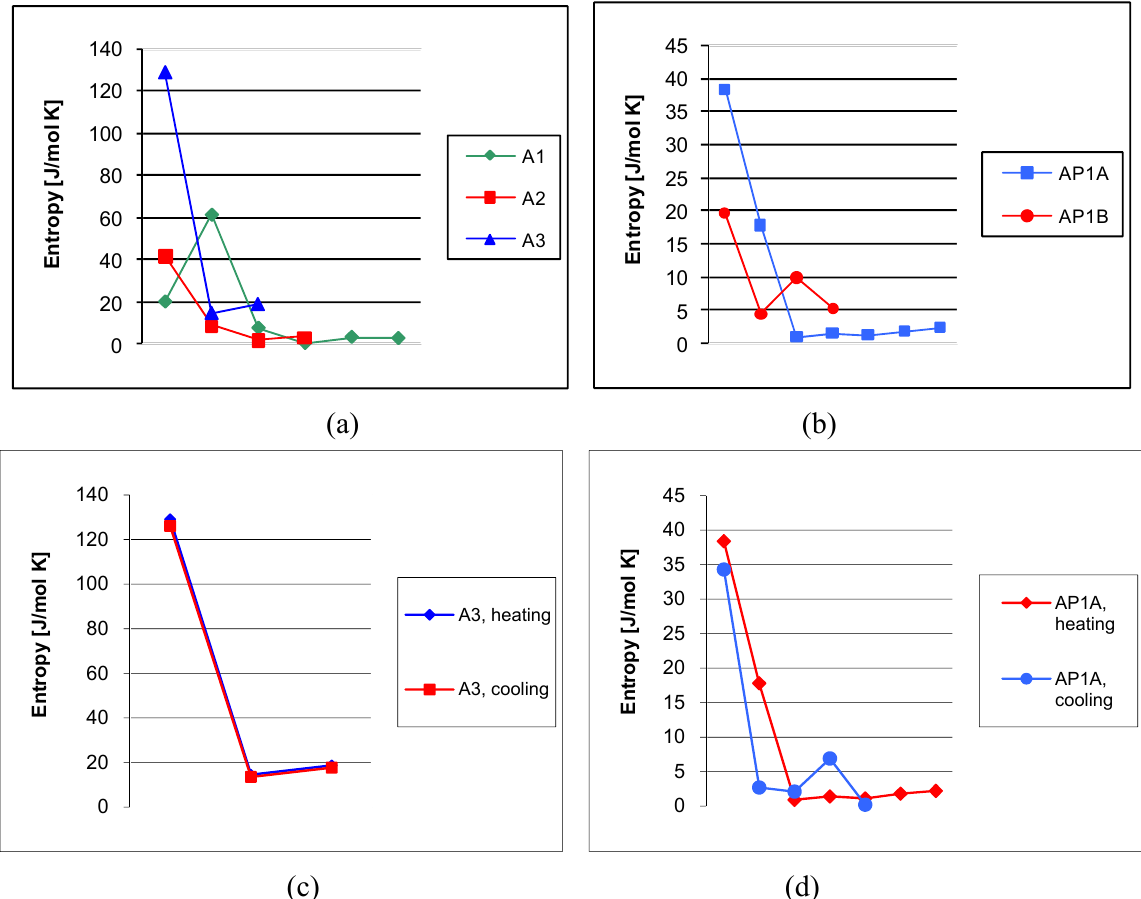
Figure 9. (a-b) Influence of the amine structure on the effect of entropy of the azomethines A1 - A3 and AP1A - AP1B during heating process. (c- d) Influence of the heating and cooling process on the effect of entropy of the azomethines A3 and AP1A